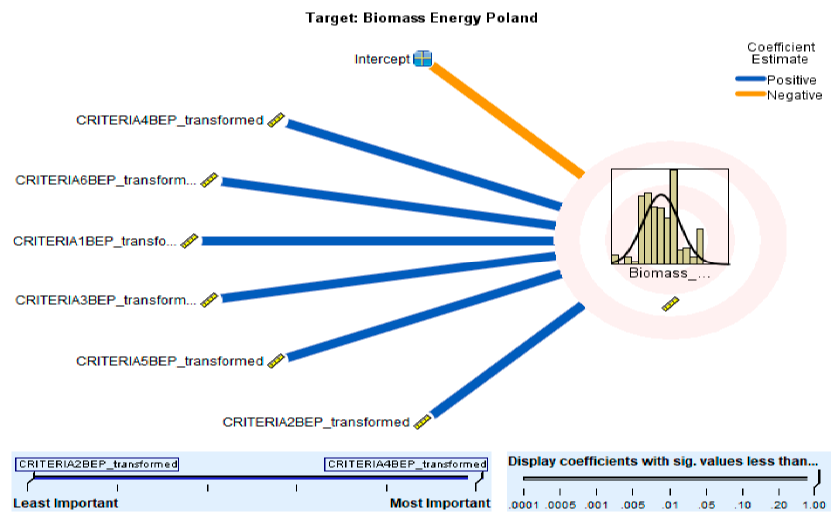
Figure 14. BE Poland GCV Criteria. Source: ALM Analysis SPSS by Author.